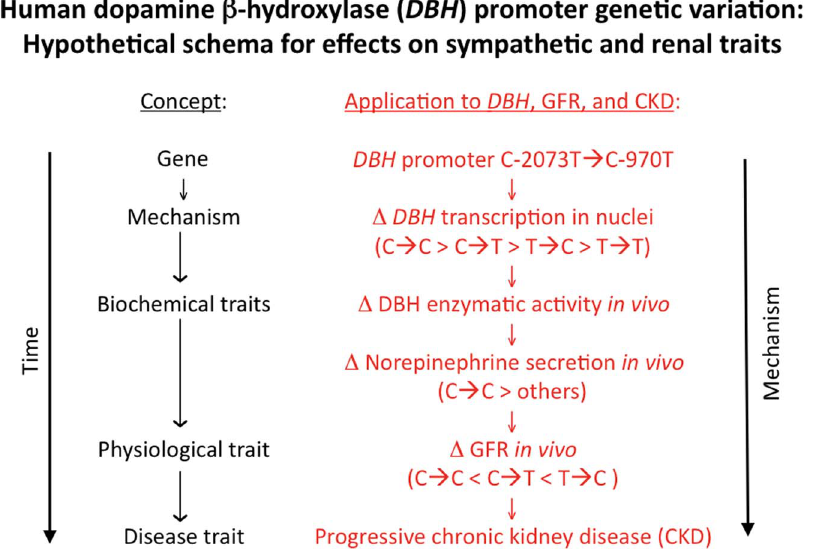
Figure 6. Human DBH genetic variation and its effects on sympathetic and renal traits: a schematic hypothesis. Framework for application of experimental results with DBH genetic variation at the promoter region: Alteration of DBH transcription and enzymatic activity affects norepinephrine, ultimately influencing GFR (physiological and disease traits).